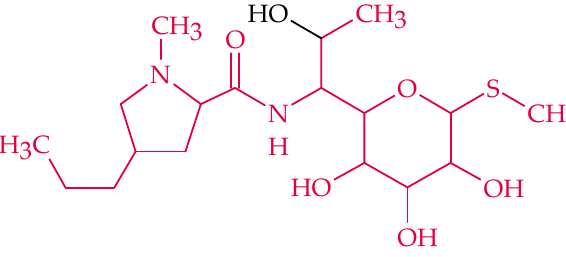
Figure 7. Chemical structure of lincomycin. The basic structure of the anthracyclines is marked in red.